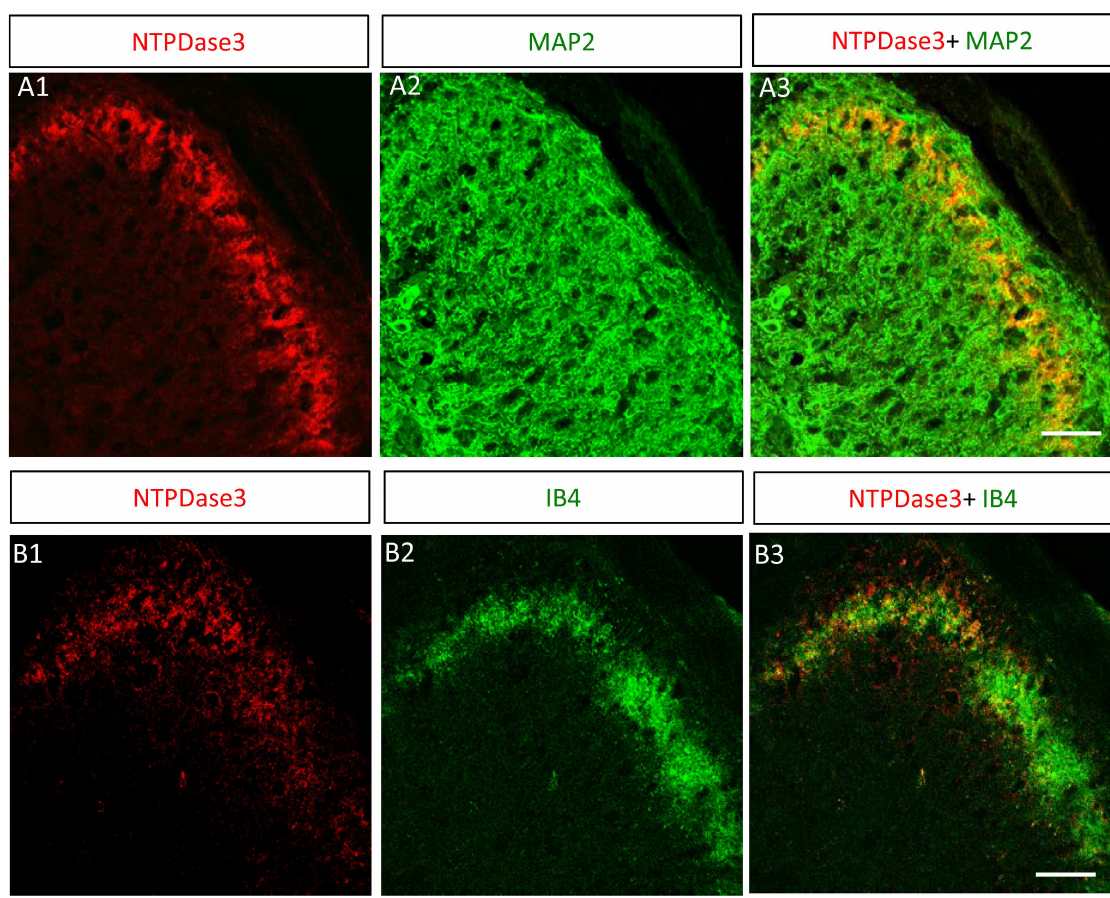
Fig 4. Expression of ecto-NTPDase3 in trigeminal subnucleus caudalis. A: Ecto-NTPDase3 is expressed in the outermost layer of the trigeminalsubnucleuscaudalis. A1: Immunostaining for ecto-NTPDase3 is detected in the brainstem at the lower level of the trigeminal subnucleuscaudalis. A2: Co-staining with neuronalmarker MAP2 shows the outline of the trigeminal subnucleuscaudalis.A3: Merged image highlightsthat NTPDase3 is expressedwithin the outermost layer of the trigeminal subnucleuscaudalis.Scale bar: 40 μ m. B: Ecto-NTPDase3 is expressed in the nociceptivelamina of the trigeminalsubnucleus caudalis. B1: Immunostaining of ecto-NTPDase3 in the brainstem at the lower level of the trigeminal subnucleuscaudalis.B2: Co-staining with the nociceptive neuronalmarker IB4 in the brainstem demonstrates the location of the nociceptive lamina of the trigeminalsubnucleus caudalis. B3: Merged image of ecto-NTPDase3 and IB4 staining shows that NTPDase3 is expressed in the nociceptivelaminaof the trigeminal subnucleuscaudalis.Scale bar: 50 μ